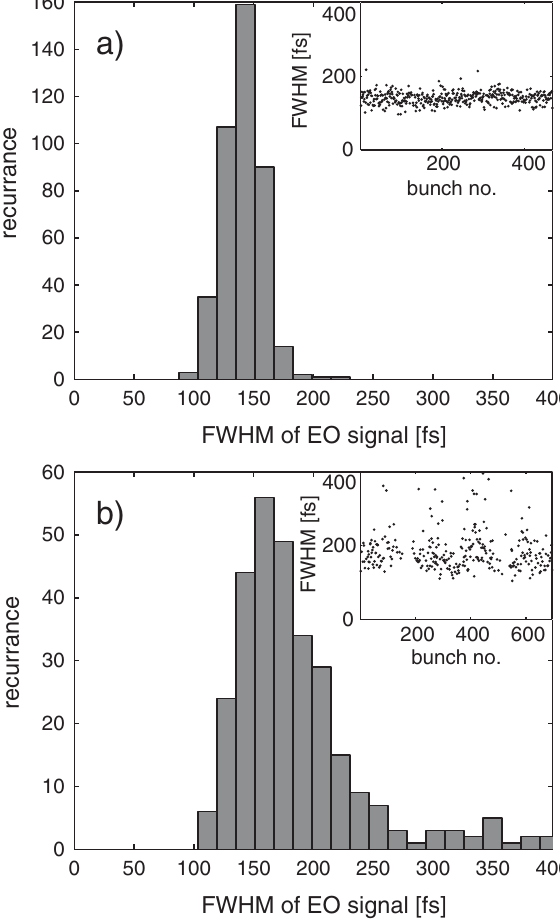
FIG. 17. EOTD signal width measured at crossed polarization. (a) Measured bunch length with the compression feedback for the rf phase of the first accelerating module in operation. (b) Measured bunch length 10 min after the feedback had been switched off.